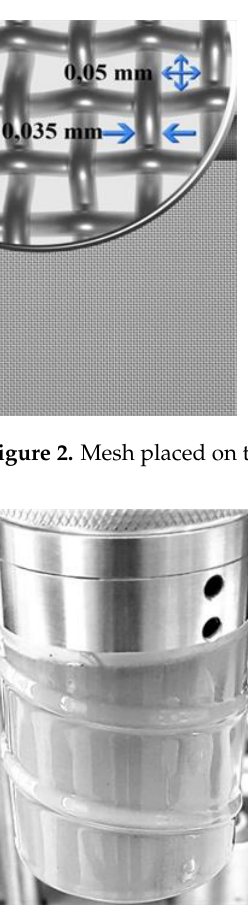
Figure 3. Rotor with a mud cake.